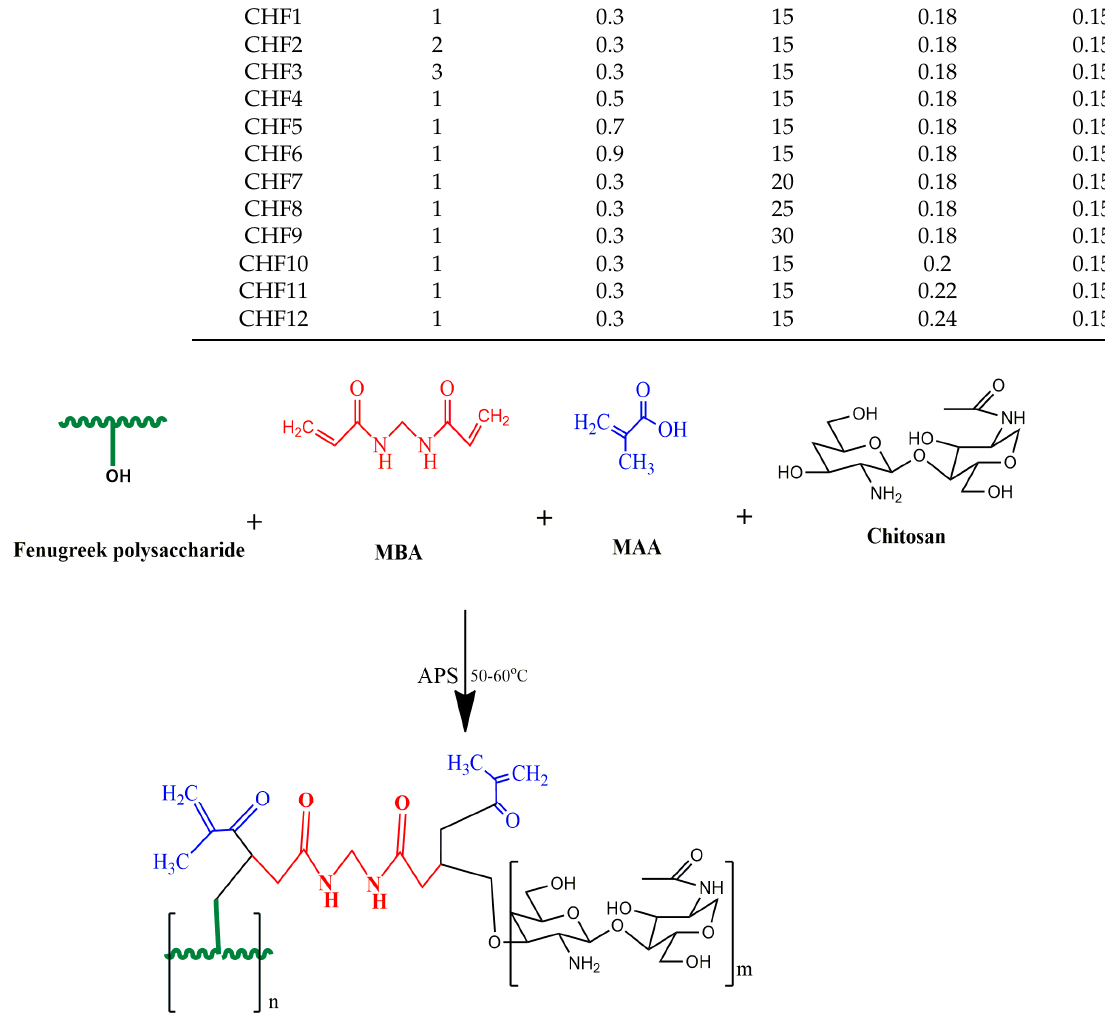
Figure 13. Proposed schematic diagram of synthesis of chitosan/fenugreek ‐ g ‐ poly (MAA) hydro ‐ gels. Table 7. Composition of Chitosan/Fenugreek ‐ g ‐ poly (MAA) Hydrogels.